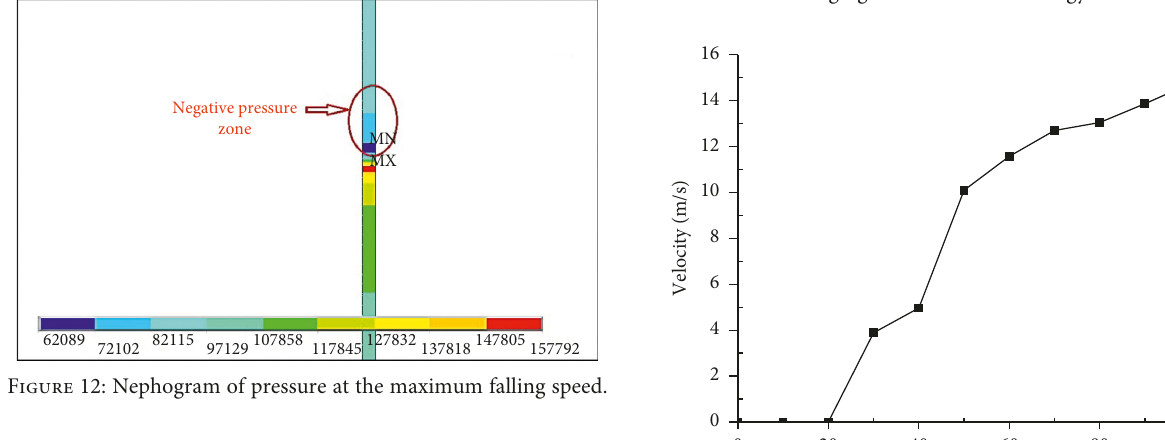
Figure 13: Changing curve of kinetic energy and air energy.